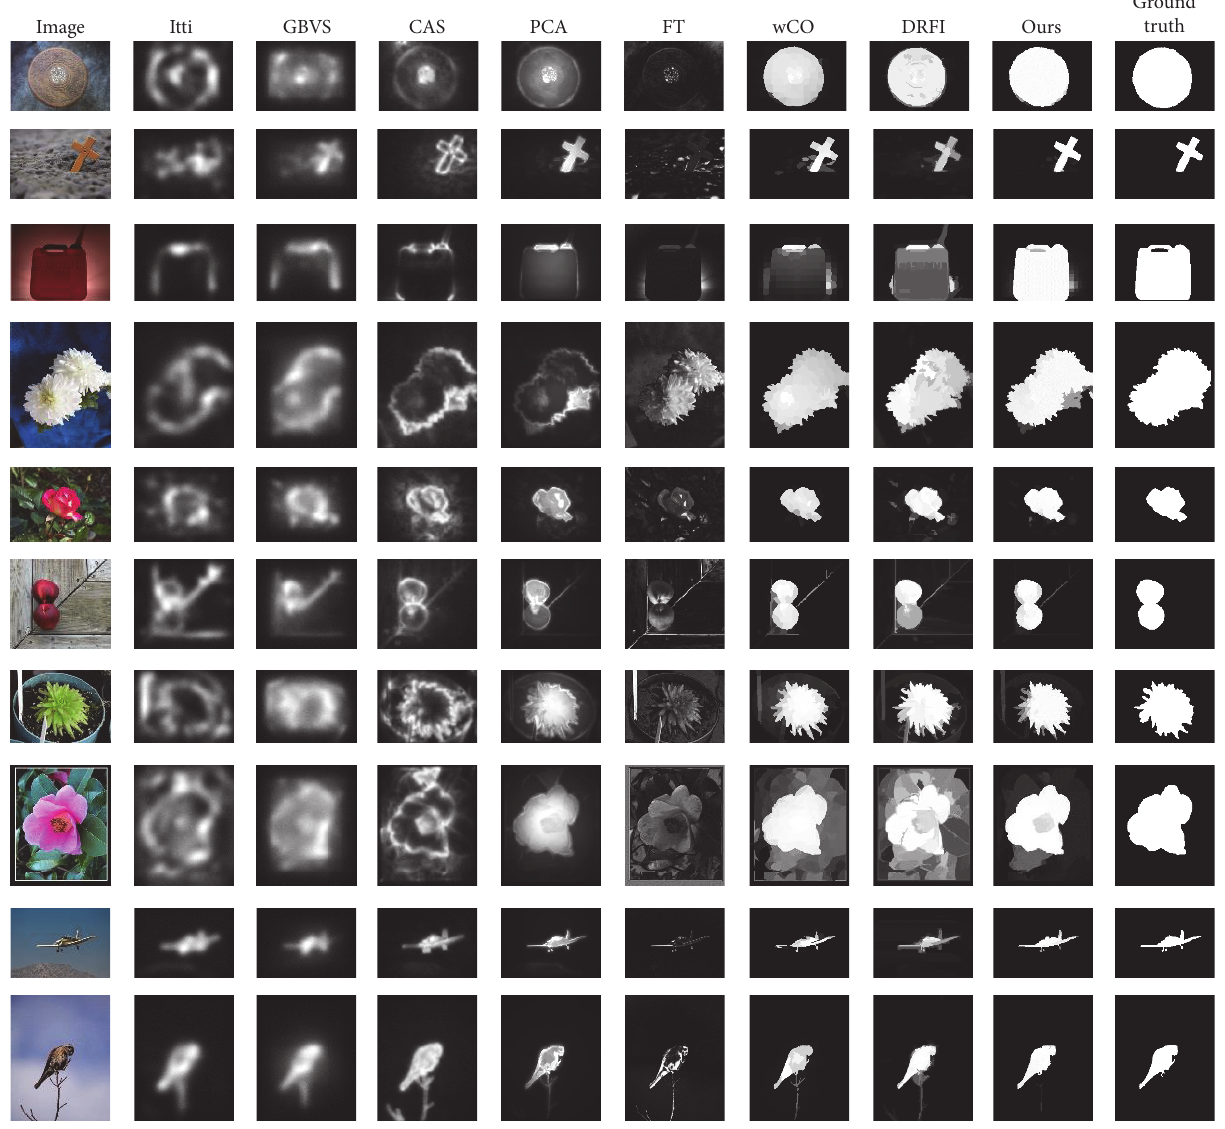
Figure 5: Visual comparison of state-of-the-art approaches to our method and ground